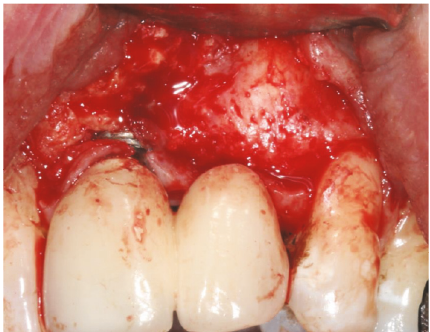
Figure 7: Classical labial “glove” reflection of buccal mucosa displaying the lack of osteogenesis of the xenograft at the buccodistal surface of the implant in position 21 with the lack of coverage of the implant